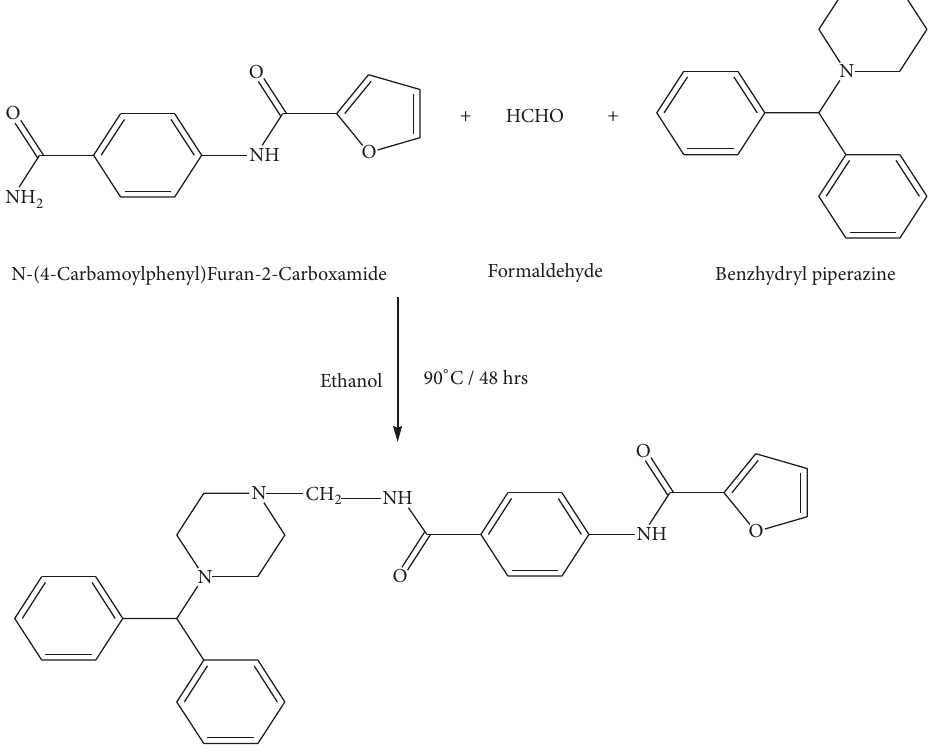
Figure 3: Synthesis of